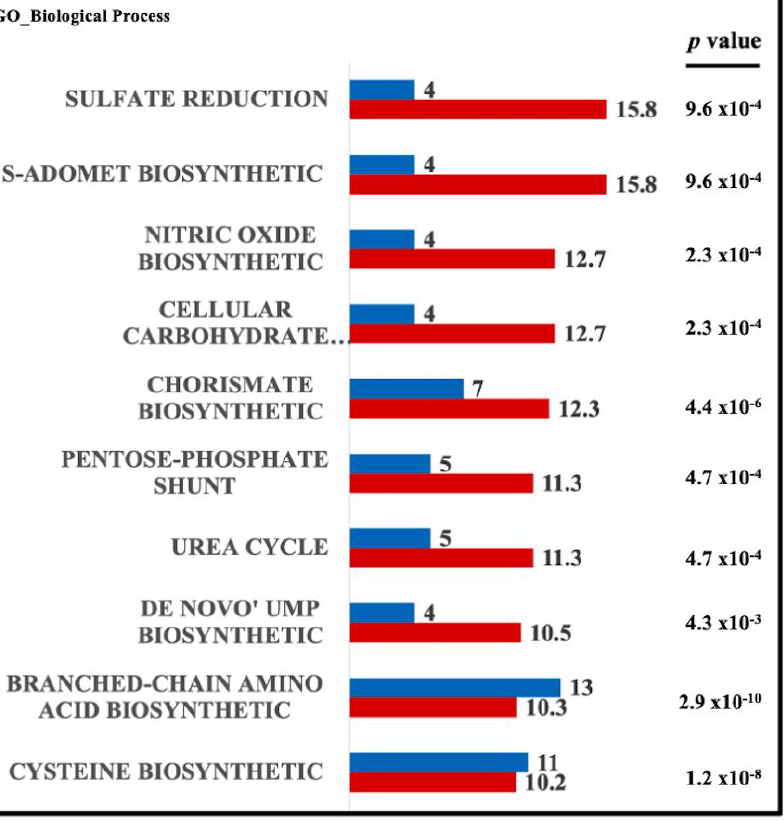
Figure 5. Overrepresented processes in cluster 1 based on Gene Ontology classification by biological process. Blue bars show the number of proteins identified in the process and red bars the fold of enrichment. The significance p value is also